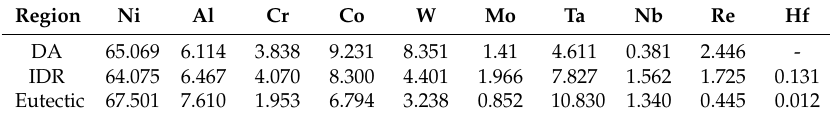
Table 6. Average chemical composition (in wt %) of DAs, IDRs and γ / γ ’ eutectics [ 26 ] .